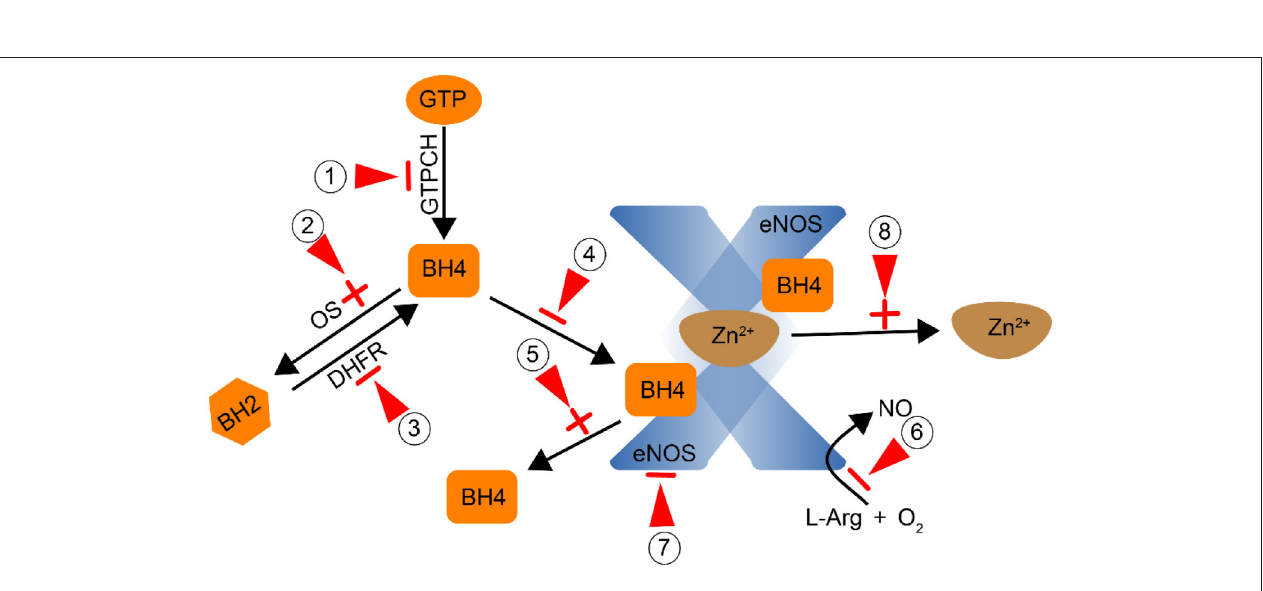
Frontiers in Cardiovascular Medicine |